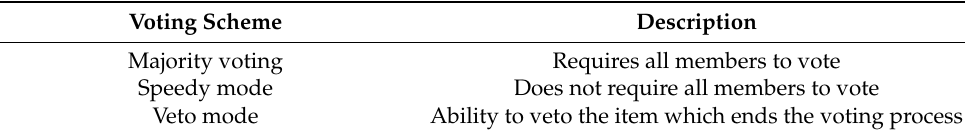
Table 1. Supported voting